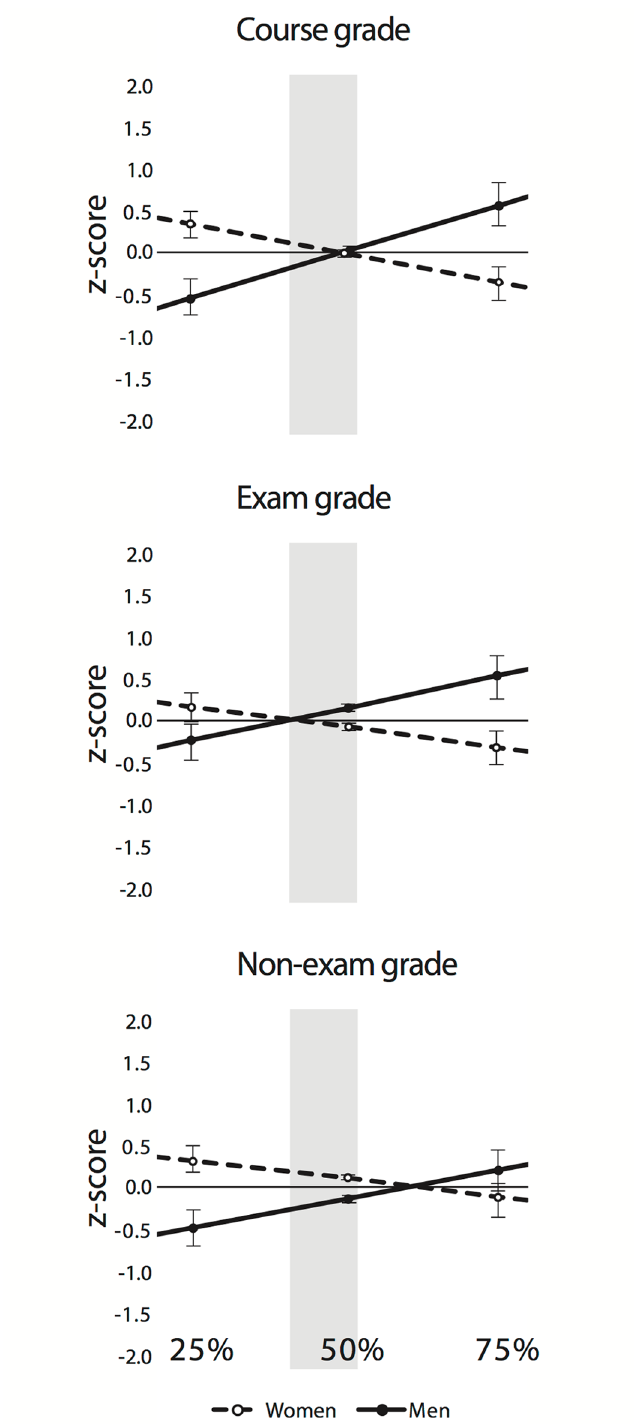
Fig 1. Expected and observed standardized course grade, exam grade, and non-exam grade ( ± SE) for women (dashed line, triangles) and men (solid line, squares) in biology when the examaccounts for 25%, 50%, or 75% of the final grade. Expected values are derived from estimated marginalmeans of performance outcomes. All values are represented as z-scores, which are negativewhen the students’ raw scores are belowthe mean, and positive when above. Solid and dashed lines represent expected performance basedon student gradesfrom nine introductory biologycourses at the University of Minnesota. The shaded regionof the graph represents courses for which we have